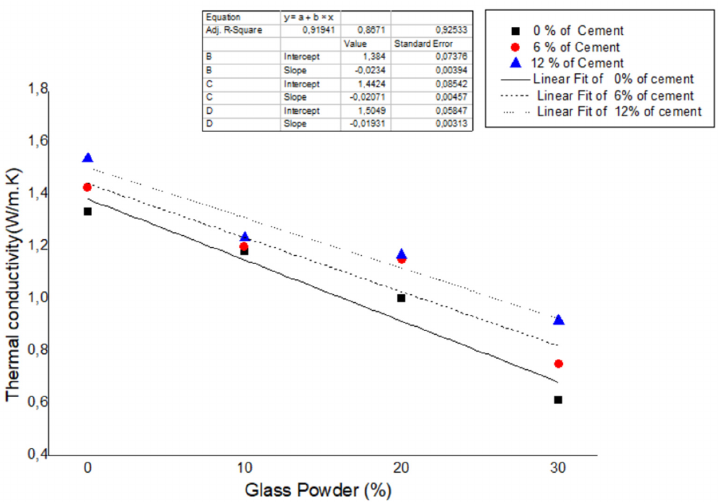
Figure 9. Variation of the measured mortars thermal conductivity in the dry state as a function of the glass powder content. The specific heat capacity measurements of cement ‐ stabilized red earth blocks as a function of glass powder substitution rate are shown in Figure 10. The specific heat of the glass powder ‐ substituted samples decreased by 45.42%. A decrease was also recorded in the glass composite material with the addition of 6% and 12% cement, respectively, vari ‐ ations of 36.90% and 25.23%. The specific heat capacity depends mainly on the volume fractions and specific heats of the different components of a composite material [27]. The decrease in the specific heat capacity of the samples with the percentage of the glass powder can be explained by the different volume fractions. The increase in the percentage of glass powder led to a decrease in the percentage of red earth. However, Nicolas et al. confirmed the decrease in the specific heat capacity of this composite material due to the low value of the specific heat of the glass (913 J/kg ∙ K) and of the air (1005 J/kg ∙ K) present in the pores [27]. Figure 10 also shows an increase in the specific heat capacity of the samples with the addition of 6% and 12% cement. This increase was due to cement particles occupying the pores, which led to a decrease in the number of empty pores. Nevertheless, the specific heat of cement is higher than that of air, which contributed to the increase in the specific heat of the ternary composite material.